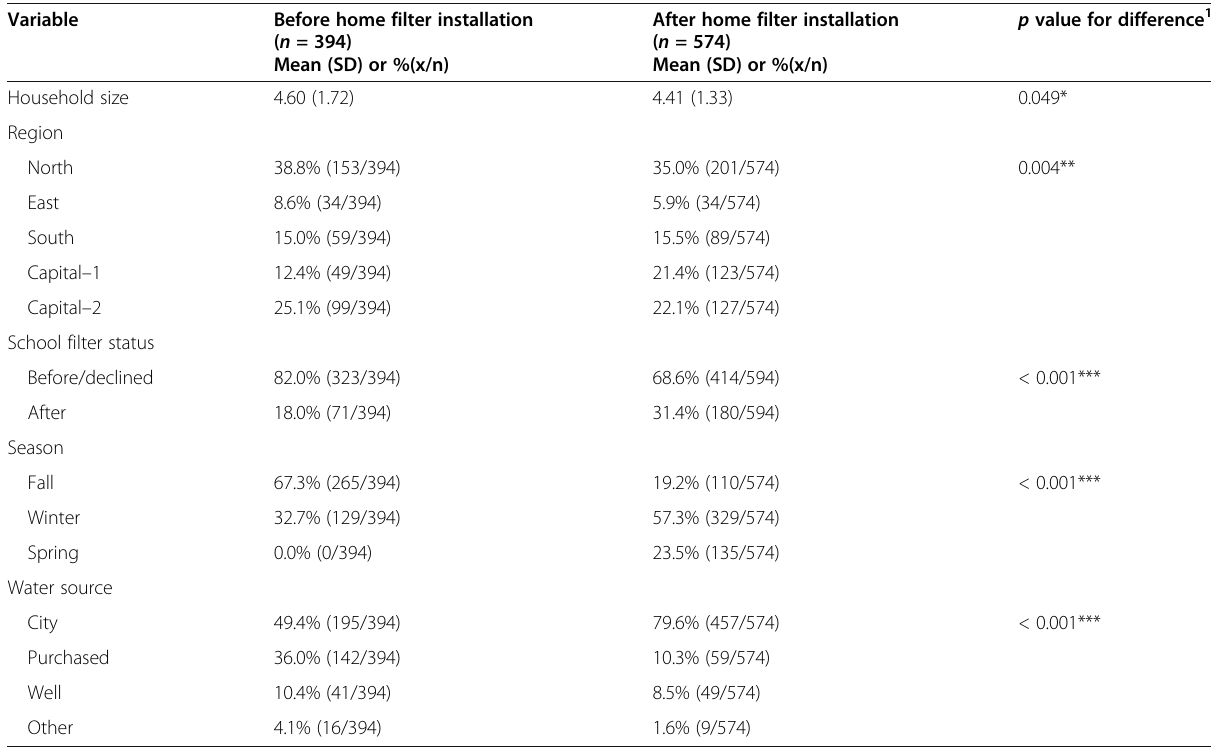
Table 2 Village